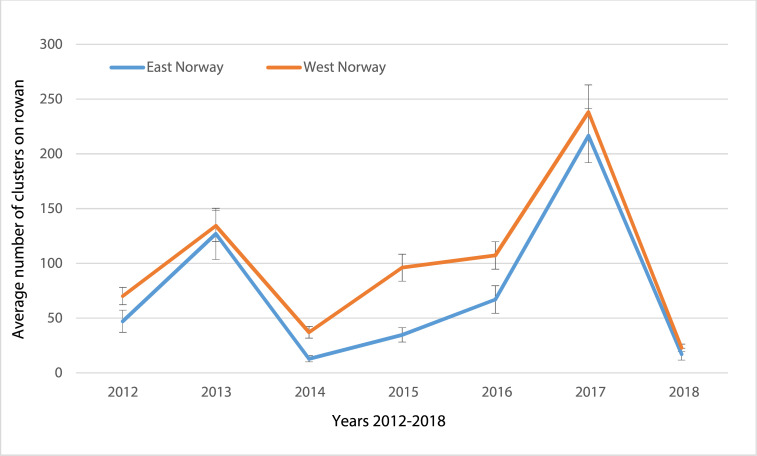
Average (±SE) number of clusters of berries on rowan in East and West Norway 2012–2018.The data were collected for the Norwegian forecasting service of apple fruit moth attacks in apple (VIPS*). Numbers are counts of rowan berry clusters on 20 reference trees at each of 21 and 38 stations in 2012, 31 and 44 stations in 2013, 30 and 44 in 2014 and 2015, 22 and 44 in 2016, 22 and 39 in 2017 and 21 and 39 in 2018, for East and West Norway, respectively. *VIPS–Open Source technology for decision support in IPM. https://www.vips-landbruk.no/applefruitmoth/ (In Norwegian).